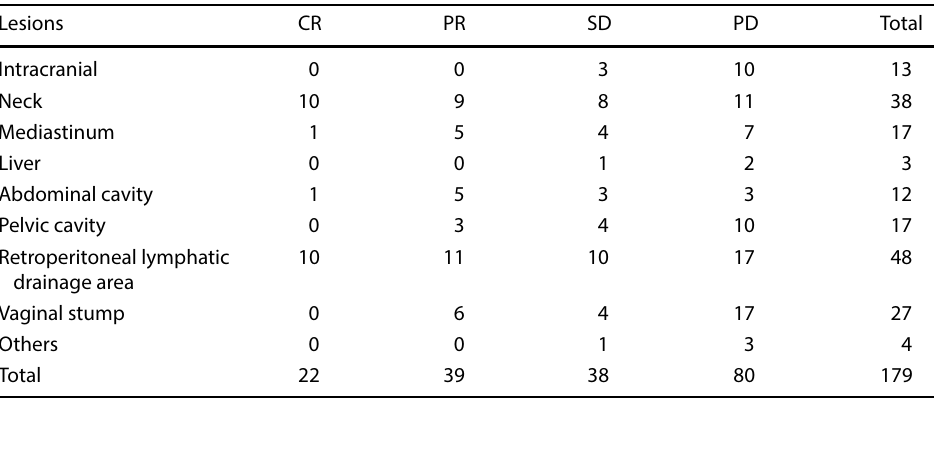
Fig. 2 Short-term curative